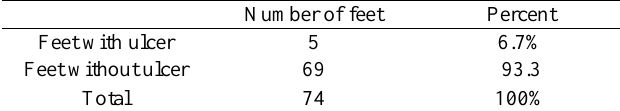
Table 1: (feet with and without ulcer)